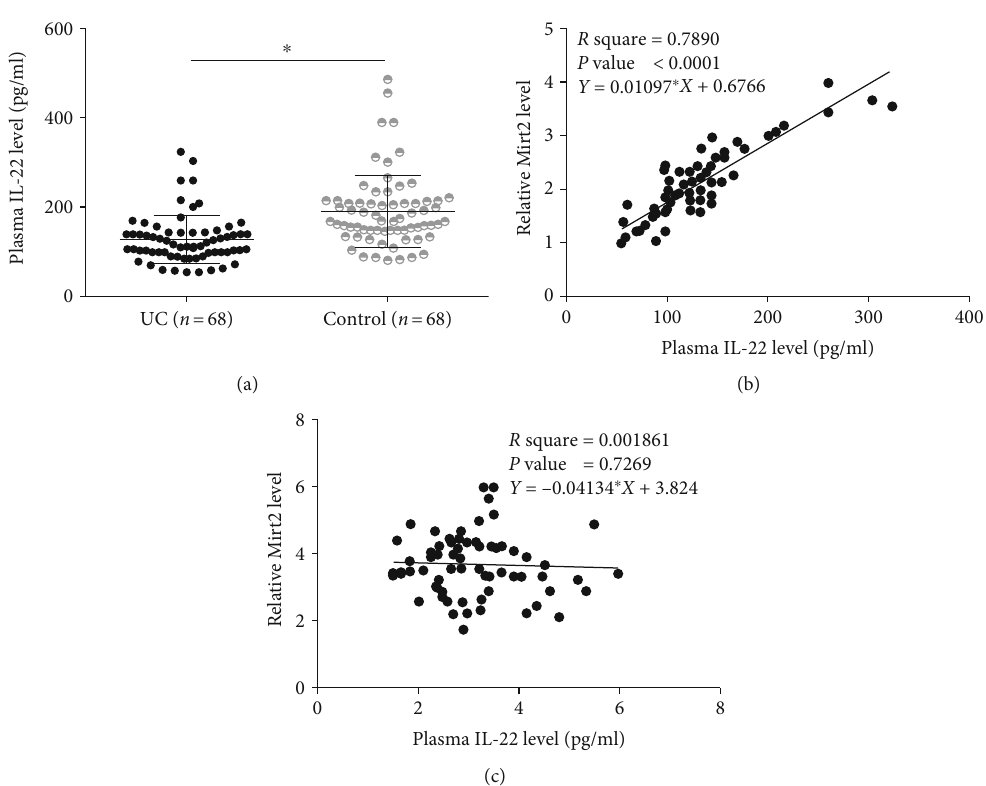
Figure 2: IL-22 was positively correlated with Mirt2 in UC patients. IL-22 in plasma of the patient ( n = 68 ) and control ( n = 68 ) groups was detected by performing ELISA, followed by data analysis by performing the unpaired t -test. Levels of IL-22 in plasma were signi fi cantly lower in the patient group than in the control group (a) ( ∗ p < 0 : 05 ). Linear regression showed that IL-22 and Mirt2 were positively and signi fi cantly correlated in UC patients (b). However, the correlation between IL-22 and Mirt2 was not signi fi cant in UC patients